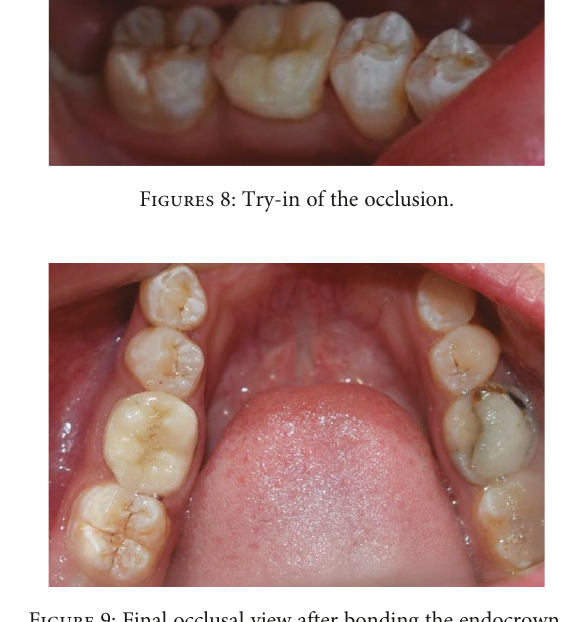
Figure 9: Final occlusal view after bonding the